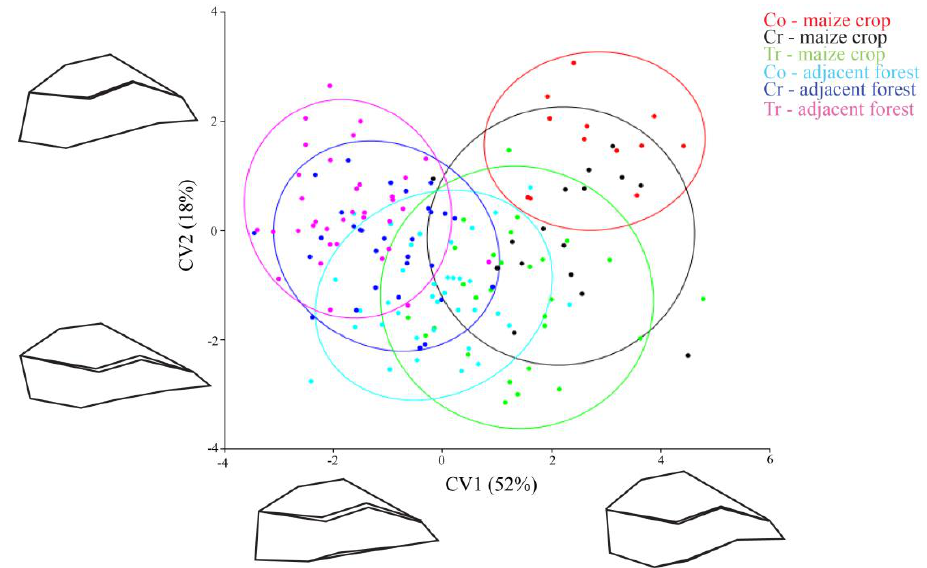
Figure 2. Position of C . quinquemaculatus populations in morphometric space formed by two main axes of Canonical Variable Analysis, collected in the region of São Miguel do Oeste, SC, Brazil. Conventional (Co), Creole (Cr) and Transgenic (Tr); ellipses indicate a 95% confidence interval.